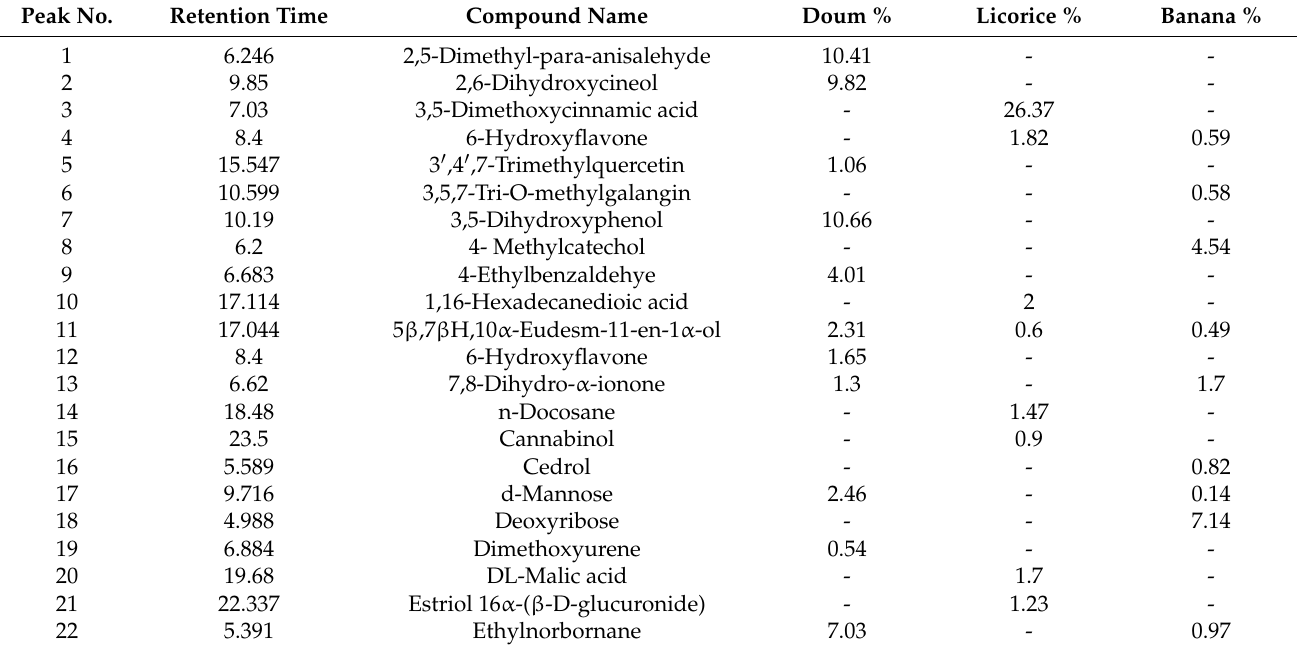
Table 7. Phytocomponents identified in the extracts of doum, licorice, and banana peels by GC–MS. Peak